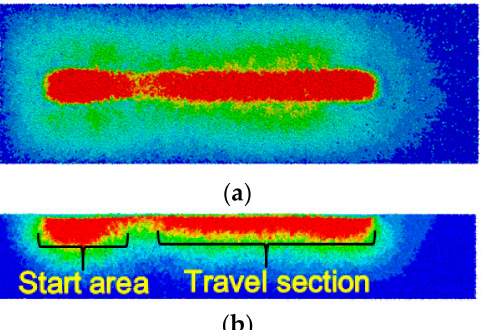
Figure 4. Soil displacement contours resulting from the passage of the press-wheel: ( a ) top view of the soil surface; ( b ) soil cross-section parallel to the travel